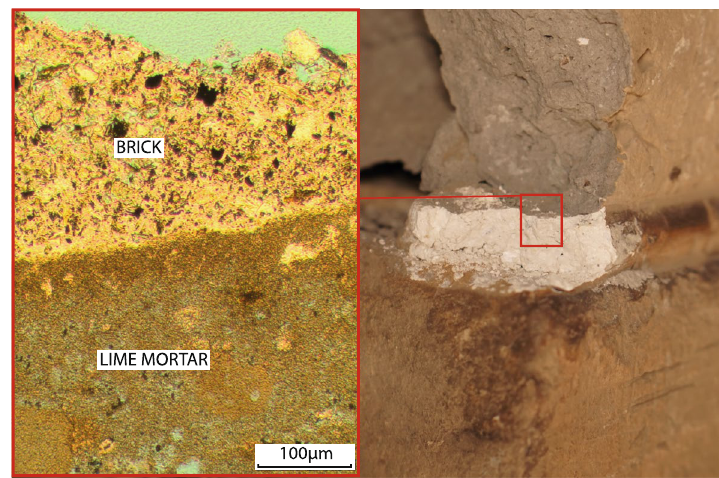
Fig. 20 Macro- and micro-scale texture of the bedding and pointing mortar in Xinguangwu. Joint width is approximately 1.0 cm (Source: Tanja Dettmering and Tongji-ACL)